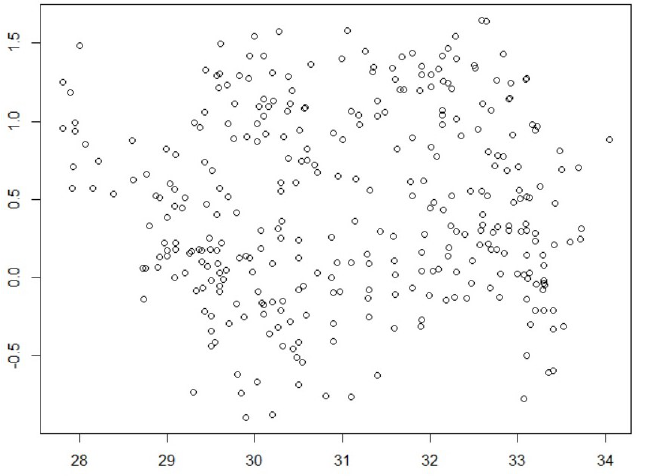
Figure 9. Plot of the residuals series ˜ z ( t ) with respect to the temperatures ˜ X ( t ) , equally spaced with one observation for each 7